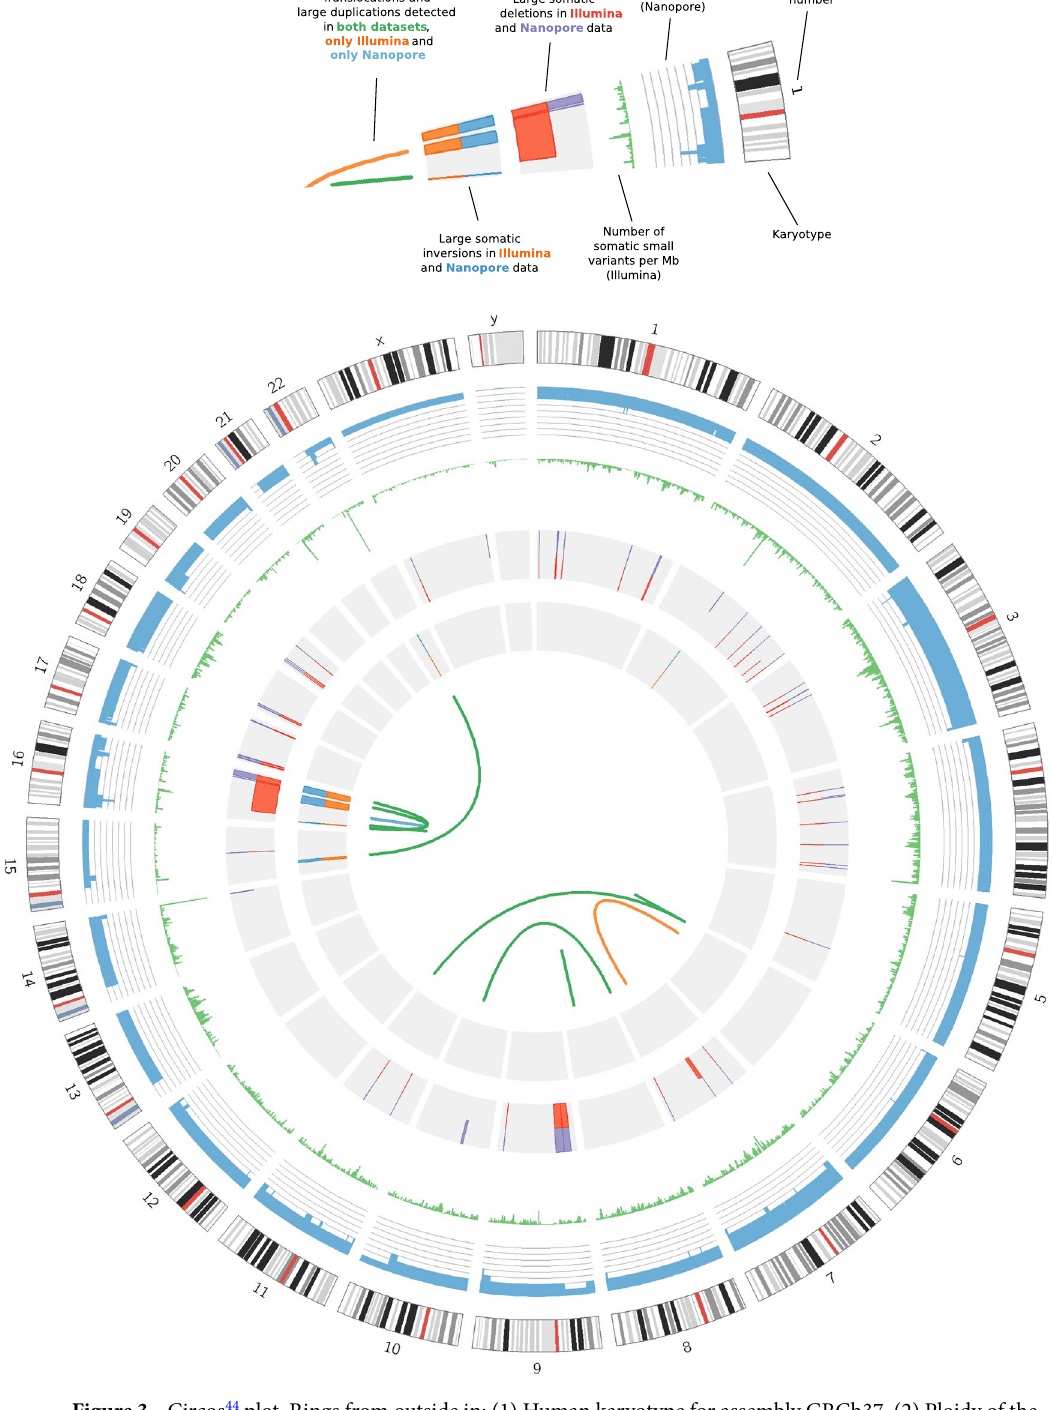
Figure 3. Circos 44 plot. Rings from outside in: (1) Human karyotype for assembly GRCh37. (2) Ploidy of the tumour sample (blue), with radial axis ranging from 0 to 8 and grey lines corresponding to each integer value. Data generated from Nanopore read counts (see Methods). (3) Number of somatic small variants per Mb in the Illumina short-read data (green). (4) Large somatic deletions detected in the Nanopore data (purple, outer half) and Illumina short-read data (red, inner half). Only those assessed as true somatic variants are shown. (5) Large somatic inversions detected in the Nanopore data (blue, outer half) and Illumina short-read data (orange, inner half). Again, only true somatic variants are shown. (6) Links denoting verified translocations and duplications detected in both datasets (green), one translocation detected only in the Illumina short-read data (orange), and one duplication detected only in the Nanopore data